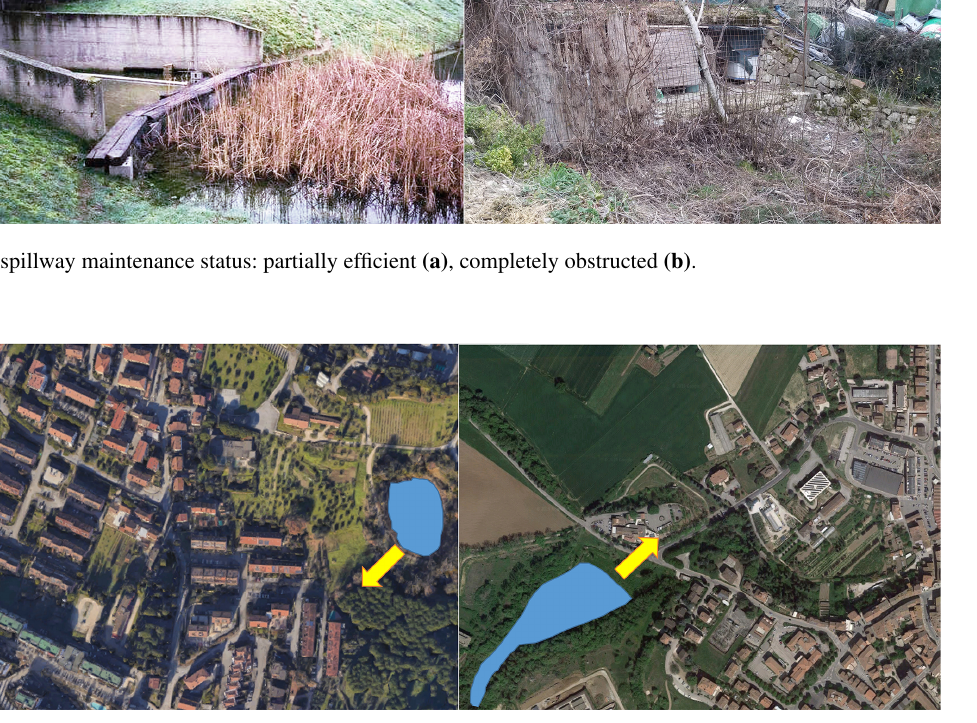
Figure 4. Examples of small reservoirs with densely built-up areas. ©Google Map source: Immagini©2018 TerraMetrics, Dati Car- tografici©2018.